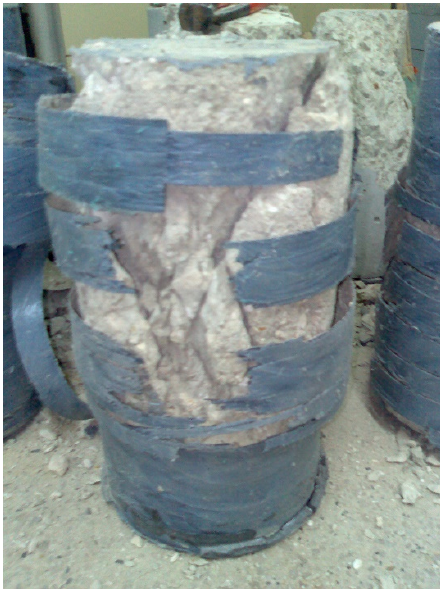
Figure 11. Photograph of a failed 150 mm × 300 mm cylinder with 40 MPa concrete and one CFRP wrap.